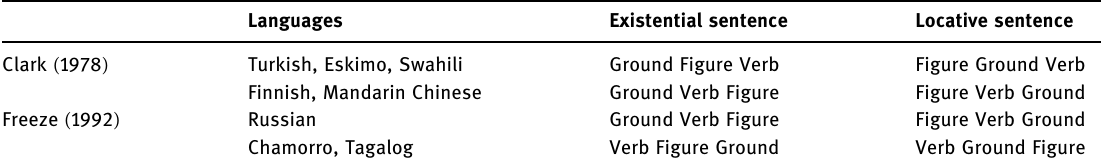
Verb Figure Ground Verb Ground